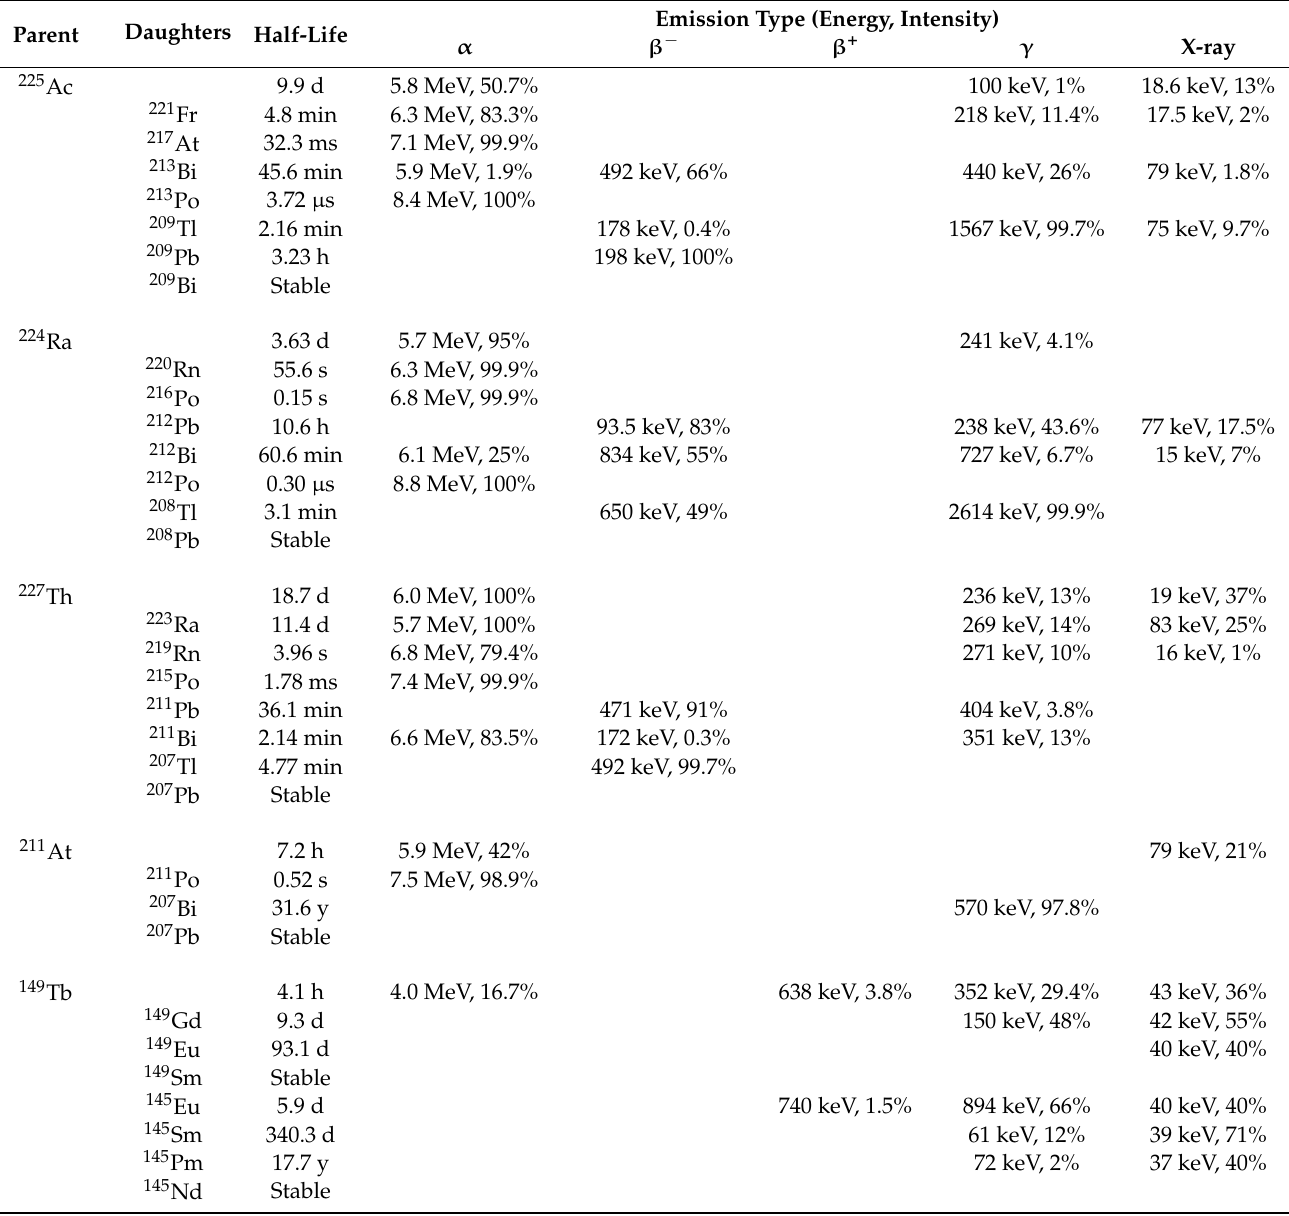
Table 2. Notable α -emitters and their daughters, half-lives, decay energies, and emission types [20].